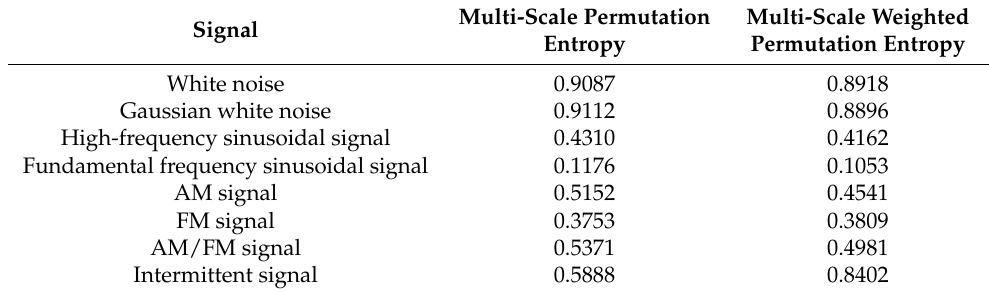
Table 1. Multi-scale permutation entropy and multi-scale weighted permutation entropy of each